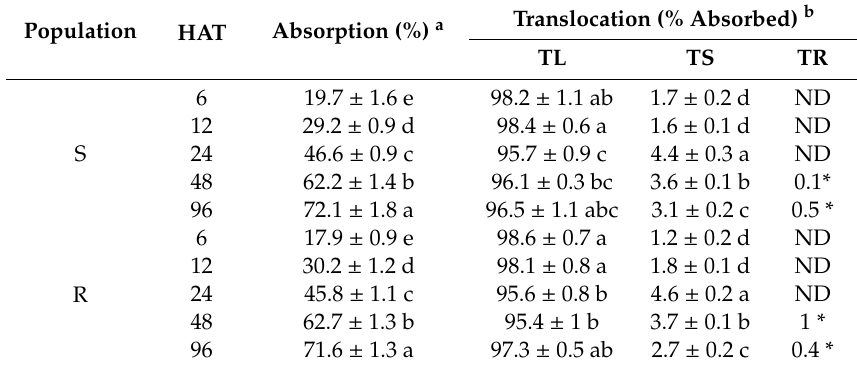
Table 5. 14 C-paraquat absorption and translocation from 6 to 96 h after treatment (HAT) in R and S P. hysterophorus